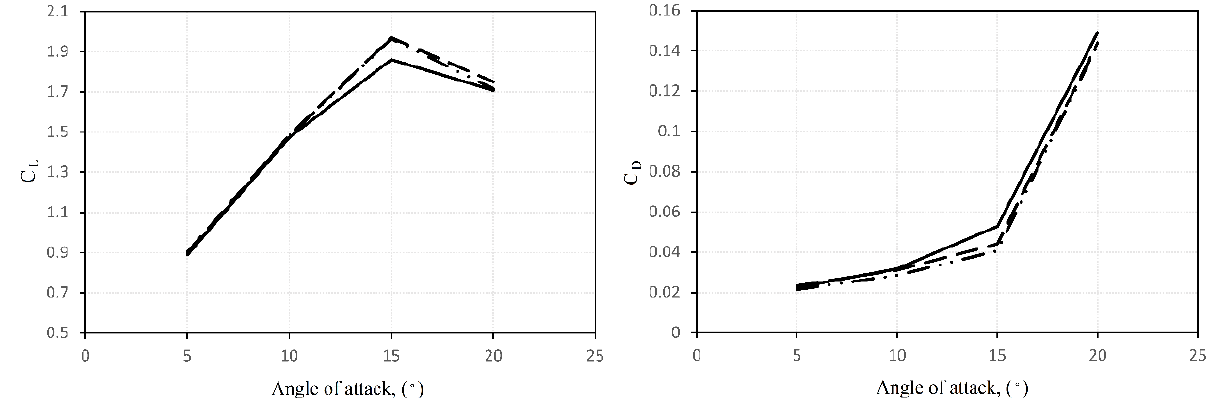
Figure 7. Lift and drag coefficients of the airfoil equipped with VGs for the three grid levels. Grid level I ( solid ), Grid level II ( dashed ), Grid level III ( dashed dot dot )